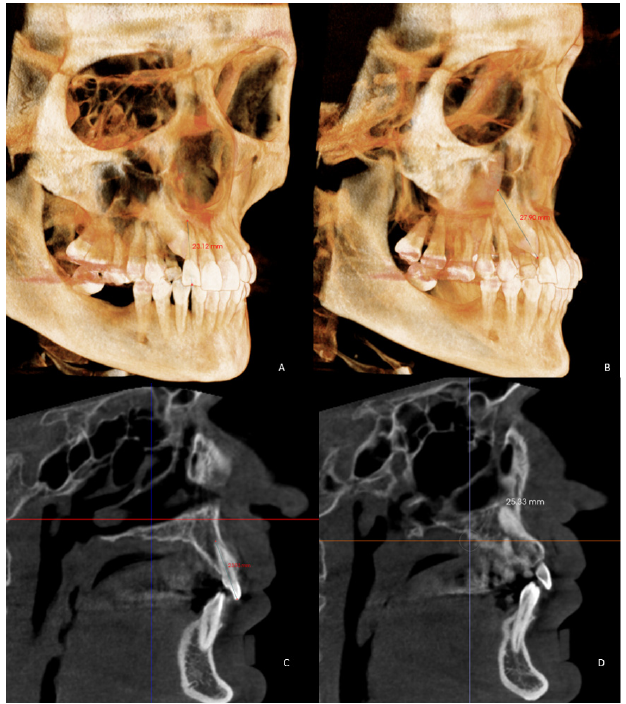
Figure 4. Images of the 3D measurements ( A , B ). CBCT reconstruction showing ( C ) total lateral incisor length (LIL) and ( B ) total canine length ( D ).